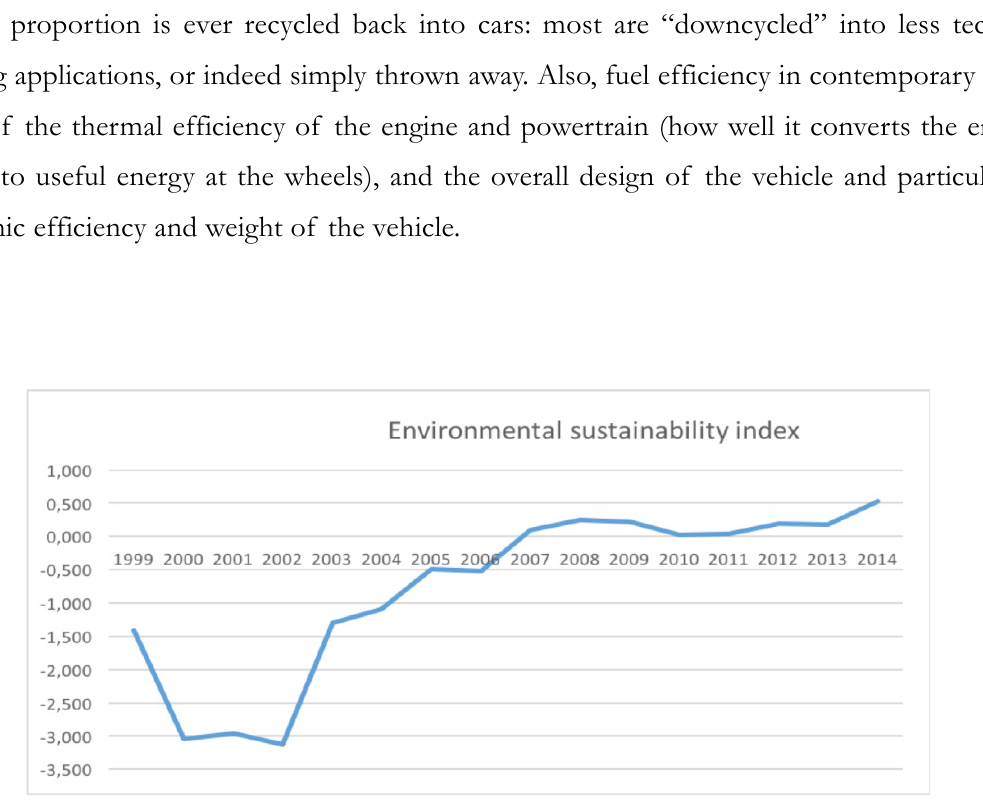
Figure 2. Evolution of the environmental sustainability